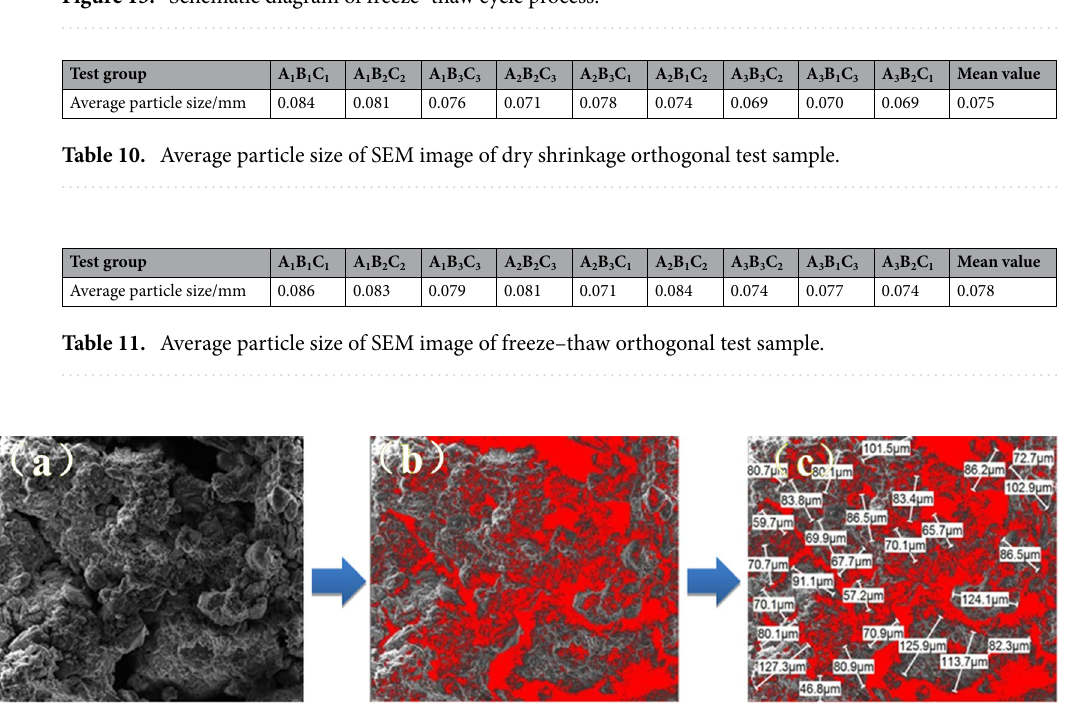
Figure 13. Schematic diagram of freeze–thaw cycle process.